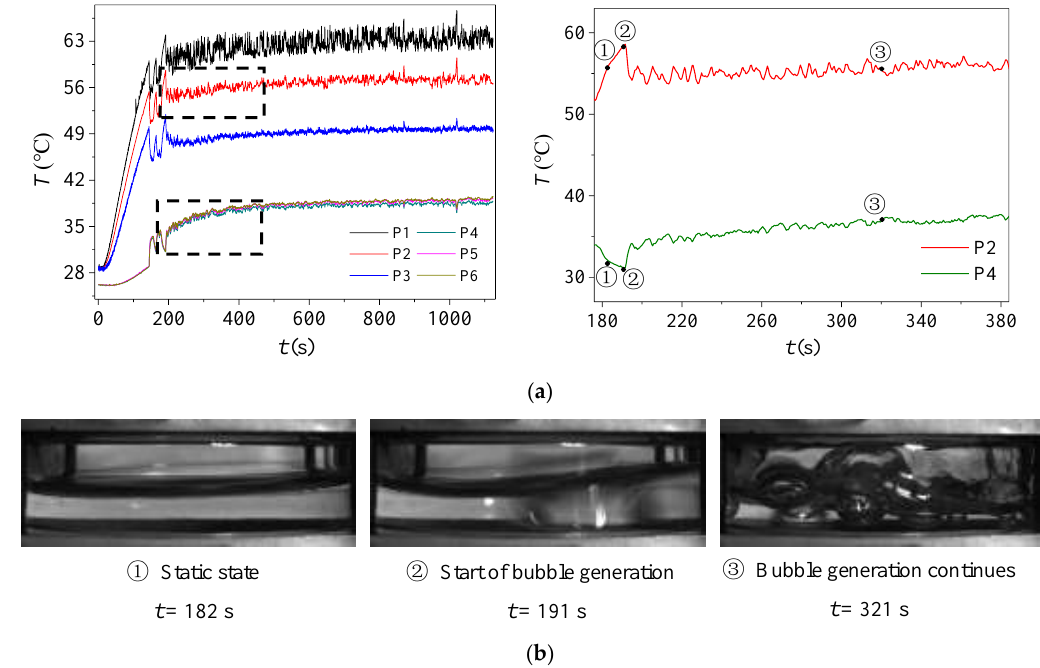
Figure 10. Continuous small-amplitude pulsation operation ( φ = 47% ， q = 19.9 W/cm 2 ): ( a ) characteristics of wall temperature pulsation; ( b ) gas–liquid two-phase behavior from the static state to continuous bubble generation.